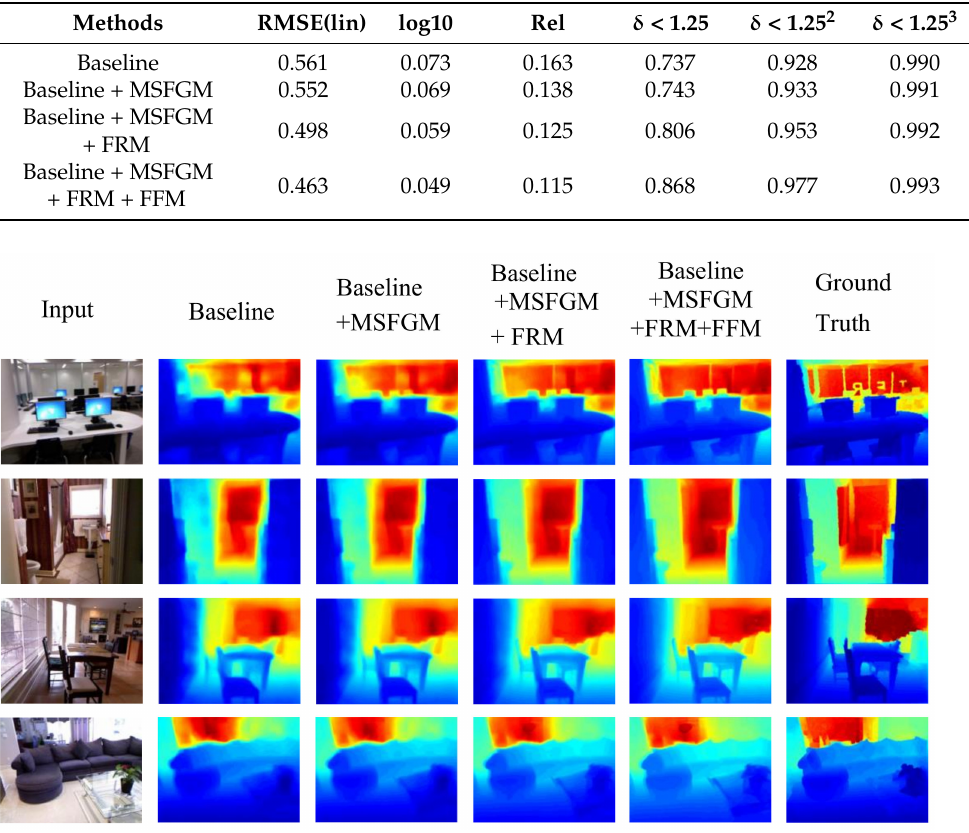
Figure 9. Depth prediction results for different